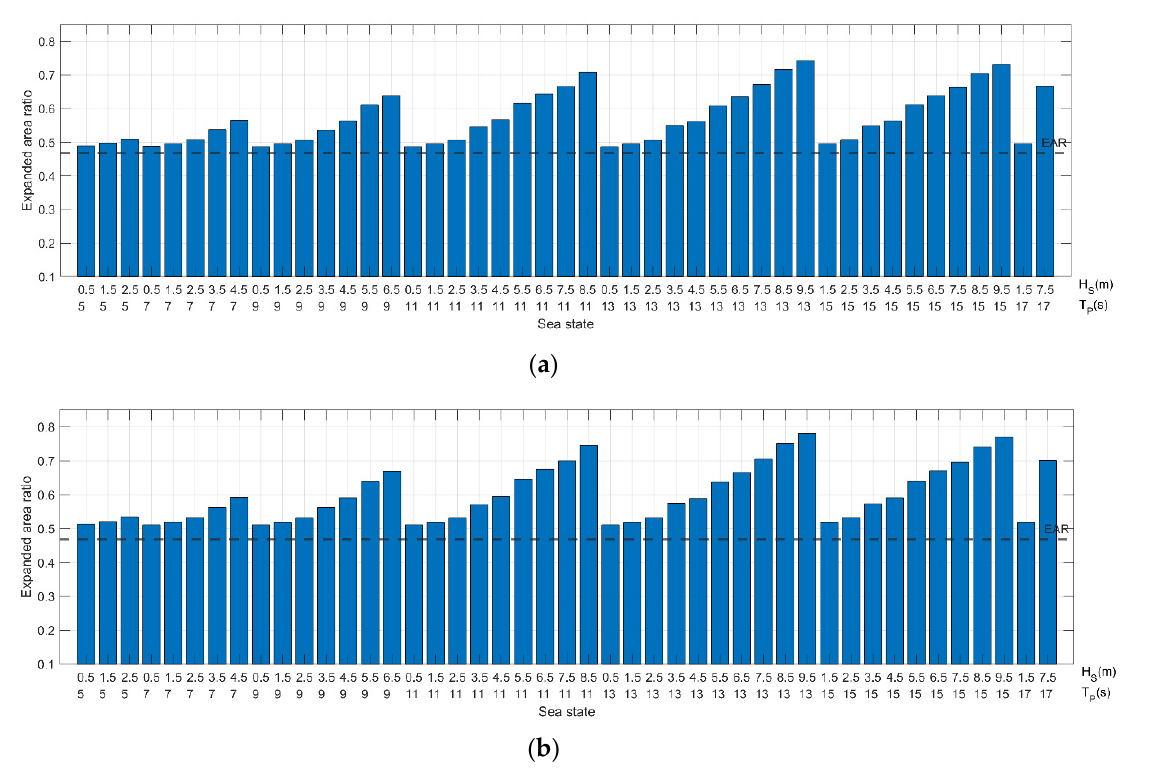
Figure 11. Variation of the minimum EAR for different sea states. Hull roughness: ( a ) 0.15 mm; ( b ) 0.55 mm.